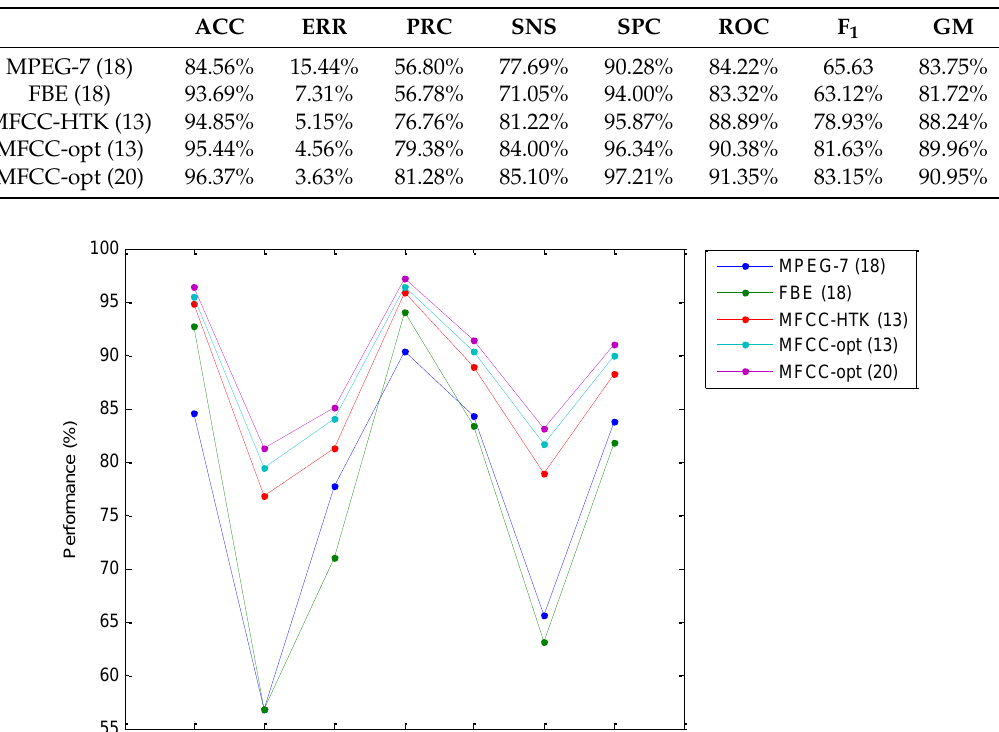
Figure 30. Classification performance using various alternatives for the representation of the anuran call spectrum. Table 10. Classification performance using different alternatives for the representation of the anuran call spectrum.